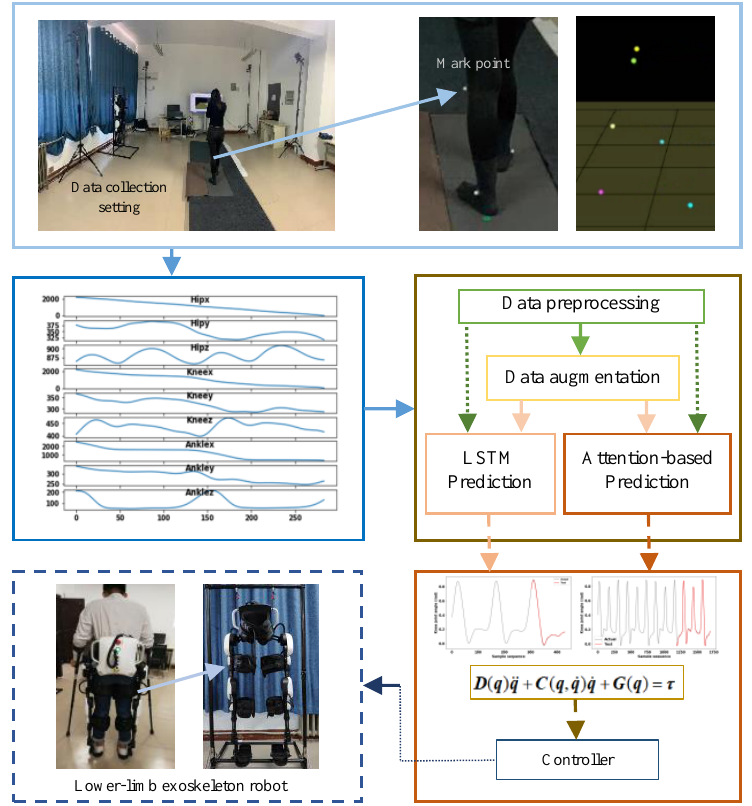
Figure 1. Gait trajectory prediction for lower-limb exoskeleton